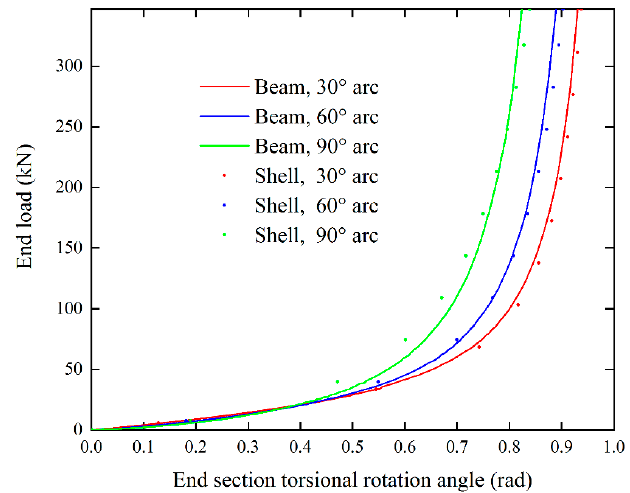
Figure 11. End-section torsional rotation of 60° pre-twisted cantilevers with different arc profile cross sections.